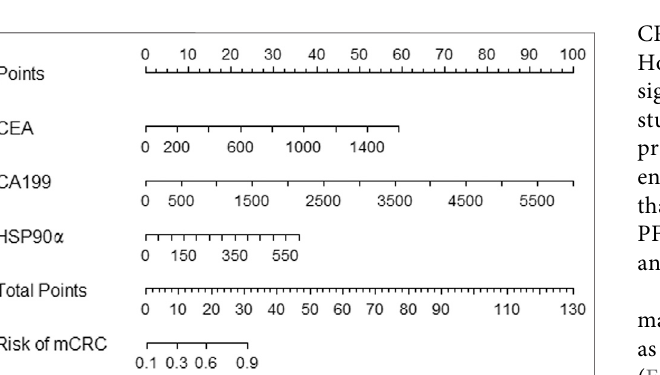
Frontiers in Molecular Biosciences |